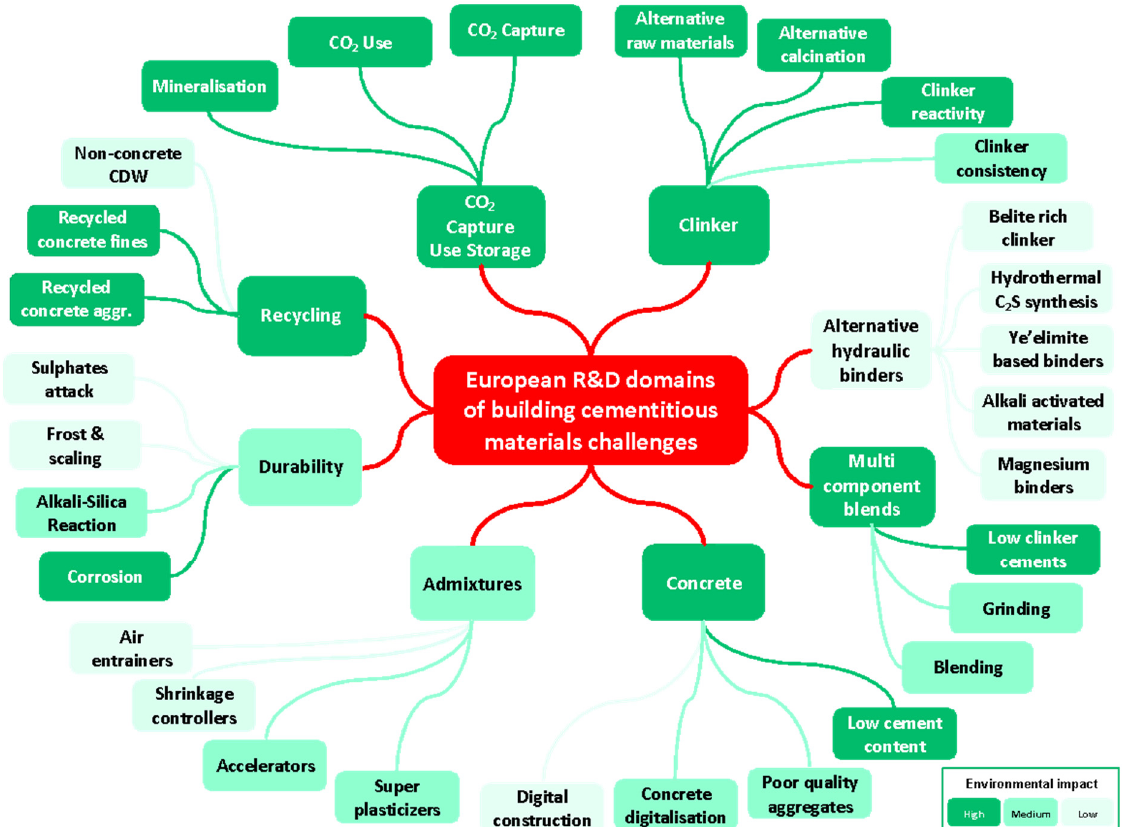
Figure A1 . Mind map of the main research topics to be explored in Europe for the ongoing